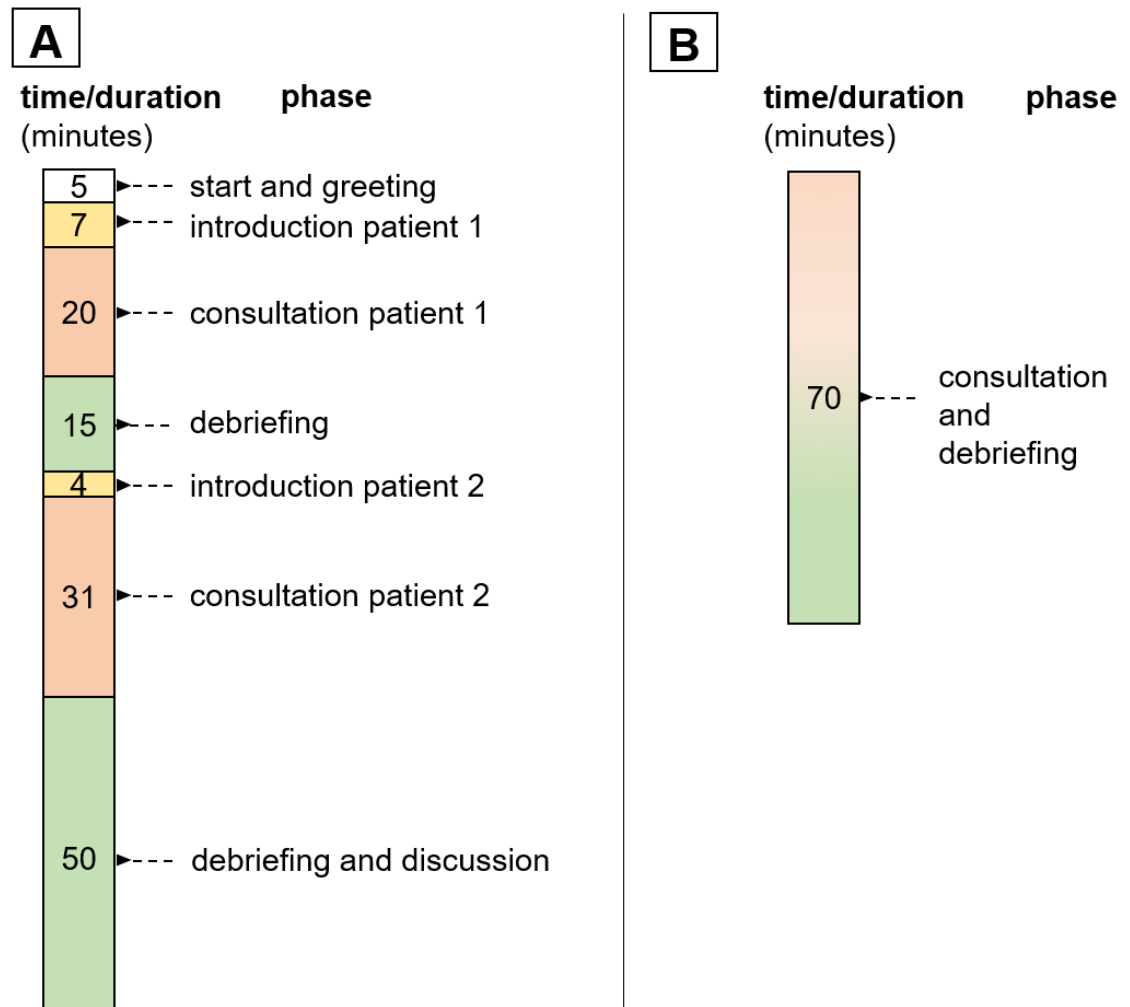
Figure 2. Timing of group appointments/element A; ( A ) individual appointments/element B ( B ).